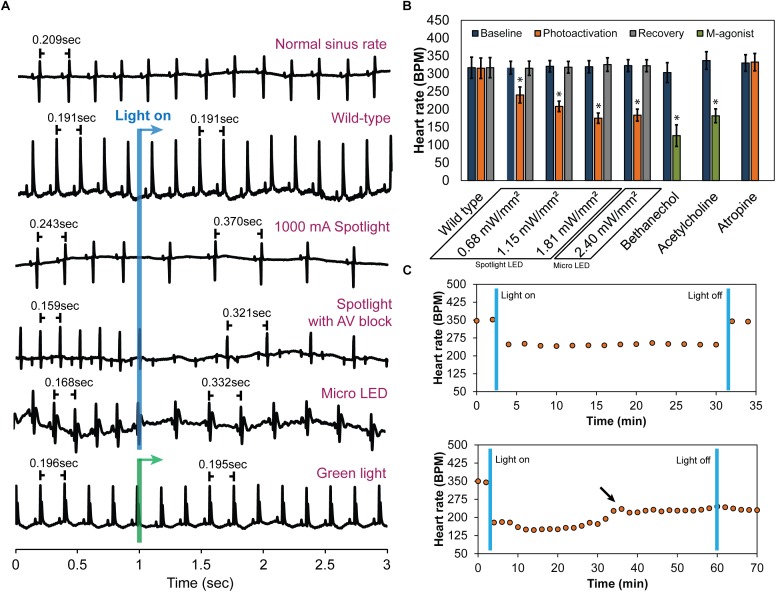
The effect of cholinergic neuron photoactivation on sinus rate and AV conduction in perfused hearts from ChAT-Cre-ChR2&EYFP mice. (A) Six representative ECG signals demonstrate the effect of cholinergic neuron photoactivation on R-R interval and AV conduction. From top to bottom: (1) Typical baseline ECG before photoactivation. (2) Typical ECG at the onset of illuminating wild-type mouse hearts with the spotlight LED. No change in the ECG was observed. (3) Typical ECG at the onset of photoactivation using the spotlight LED at the highest source current. RR interval increased immediately. (4) Representative ECG showing AV block when illuminating the RA and AV node with the spotlight LED at the highest source current. Second-degree AV block was observed. (5) Typical ECG at the onset of photoactivation using the micro LED placed on top of the RA. RR interval increased immediately. (6) Representative ECG showing no change in HR at the onset of green light (peak 520 nm) illumination of the RA of ChAT-Cre-ChR2&EYFP mouse hearts. (B) Average HR changes (n = 10 hearts) at baseline, during photoactivation of the RA at four different irradiances (with either the spotlight or micro LED), and after cessation of illumination. Average HR changes are also shown for wild-type mice with no ChR2 expression (n = 5 hearts) and for the muscarinic agonists bethanechol (10 μM, n = 9 hearts) and acetylcholine (800 μM, n = 9 hearts). The muscarinic antagonist atropine (50 nM, n = 9 hearts) completely blocked changes in HR during photoactivation by the spotlight (1.81 mW/mm2) and the micro LED (2.4 mW/mm2). (C) Robustness and stability tests were performed to assess the effect of prolonged photoactivation (n = 3 hearts). Top: change in HR during 30 min of photoactivation. HR returned to baseline upon cessation of illumination. Bottom: change in HR during 60 min of photoactivation. The arrow indicates that the potency of photoactivation was reduced after 35–40 min of illumination. HR did not return to baseline until 20 min after cessation of illumination (data not shown).